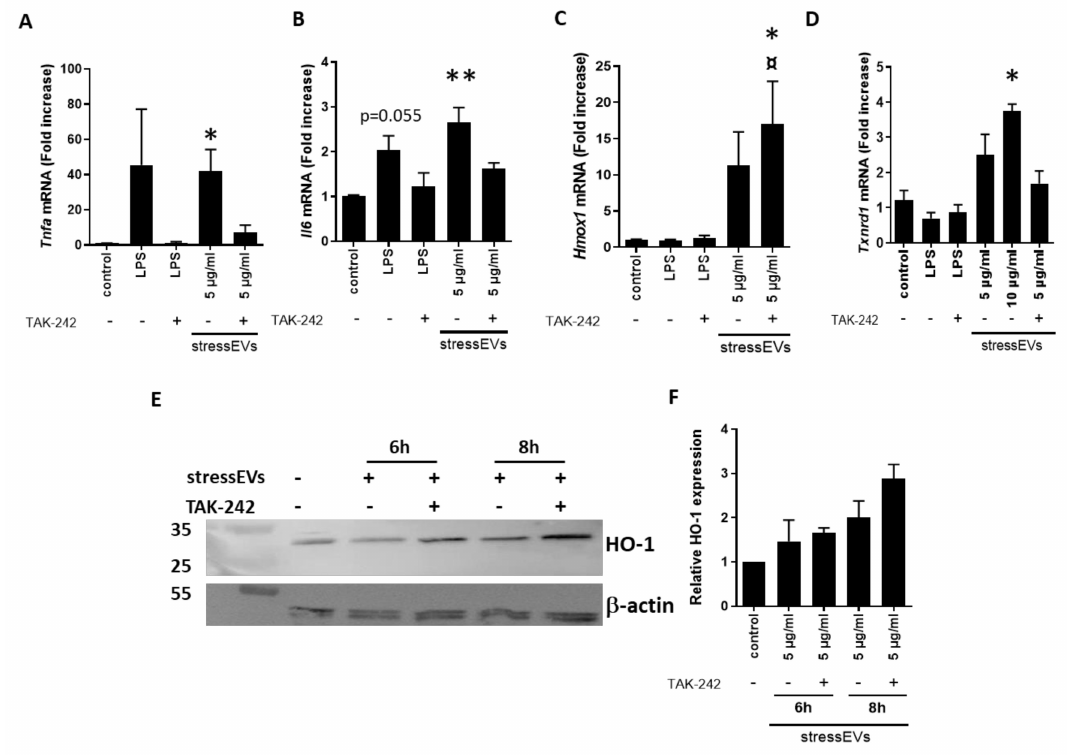
Figure 3. StressEVs activate cardioprotective signaling pathways in H9c2 cells, independently of TLR4 signaling. ( A – D ) H9c2 cells were stimulated for 6 h with stressEVs (5 or 10 µ g / mL) or LPS (10 ng / mL) in the absence or presence of TAK-242 (2.5 µ M). Tnfa Il6 , Txnrd1 , and Hmox1 mRNA levels